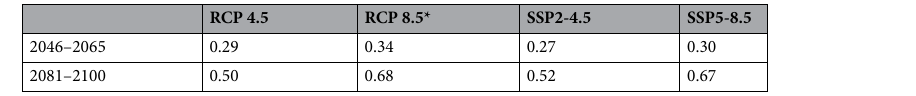
Table 2. Mean sea level change (m) projections for the Portuguese Coast. The asterisk represents the scenarios considered in flood